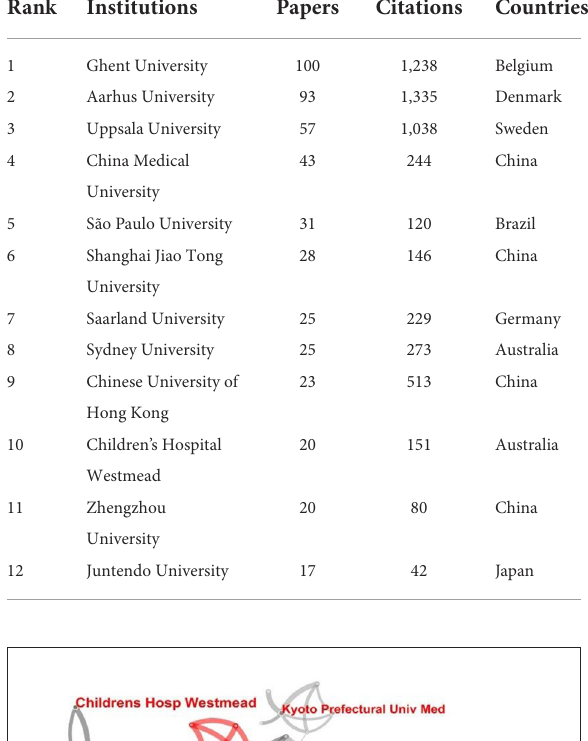
TABLE 3 The top 10 institutions of publications volume on NE from 1982 to 2022.